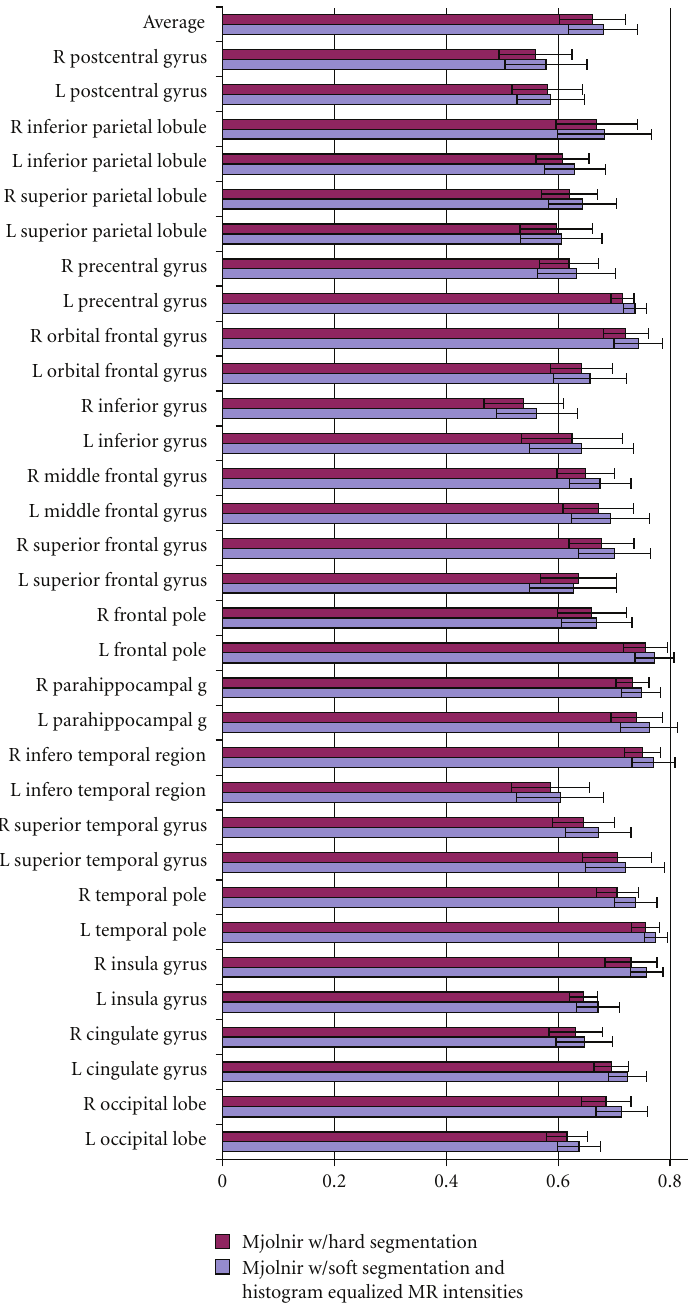
Figure 8: Average Dice coe ffi cients for di ff erent anatomical regions on the left and right hemisphere (labeled L and R) for Mjolnir registration using hard segmentation exclusively (as in HAMMER) versus using fuzzy (or soft) segmentation and histogram equalized MR intensities in the attribute vector. The top set of bars shows the average over all regions, and the error bars represent one standard deviation in each